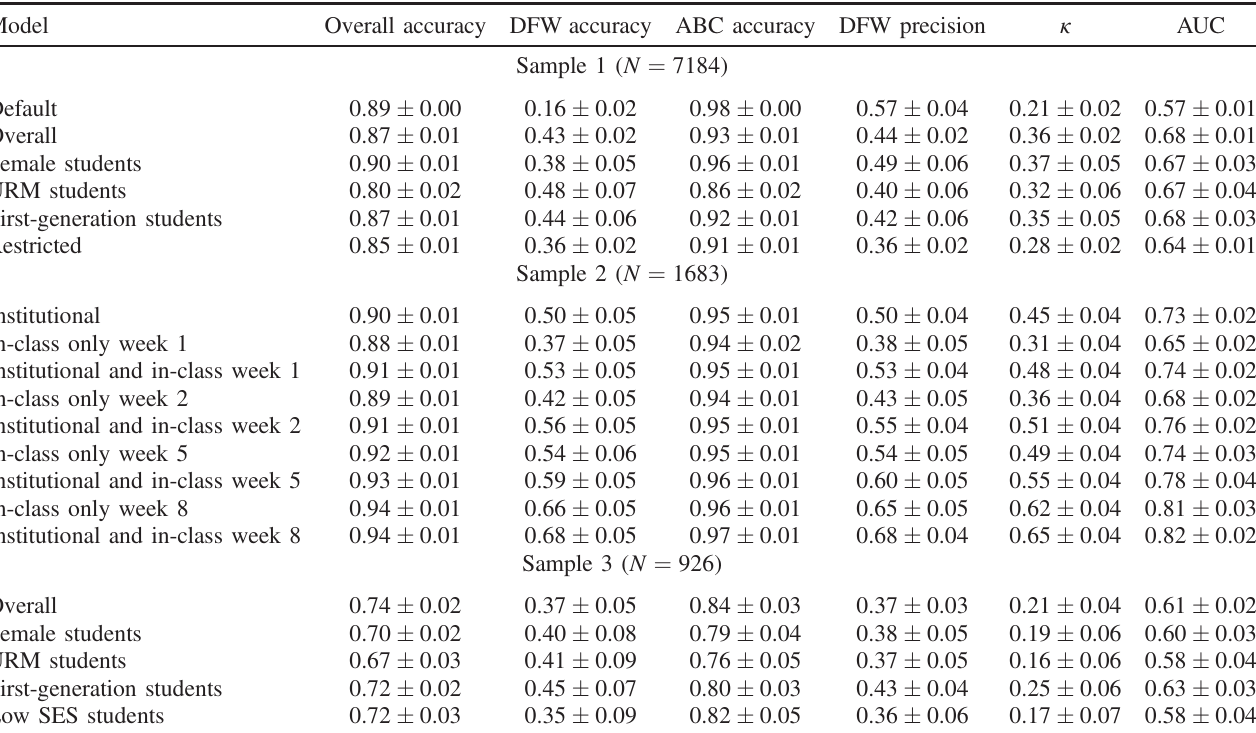
TABLE V. Model performance parameters. Values represent the mean (cid:2) the standard deviation.